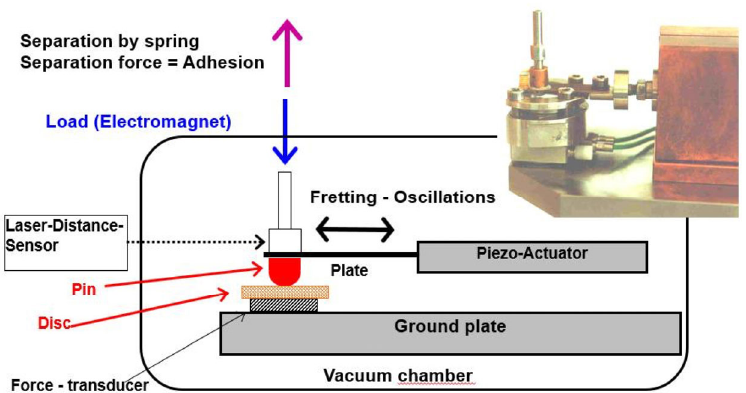
Fig. 30 A fretting tester for simulating cold welding in HDRMs [286]. Reproduced with permission from Ref. [286], © The author(s),